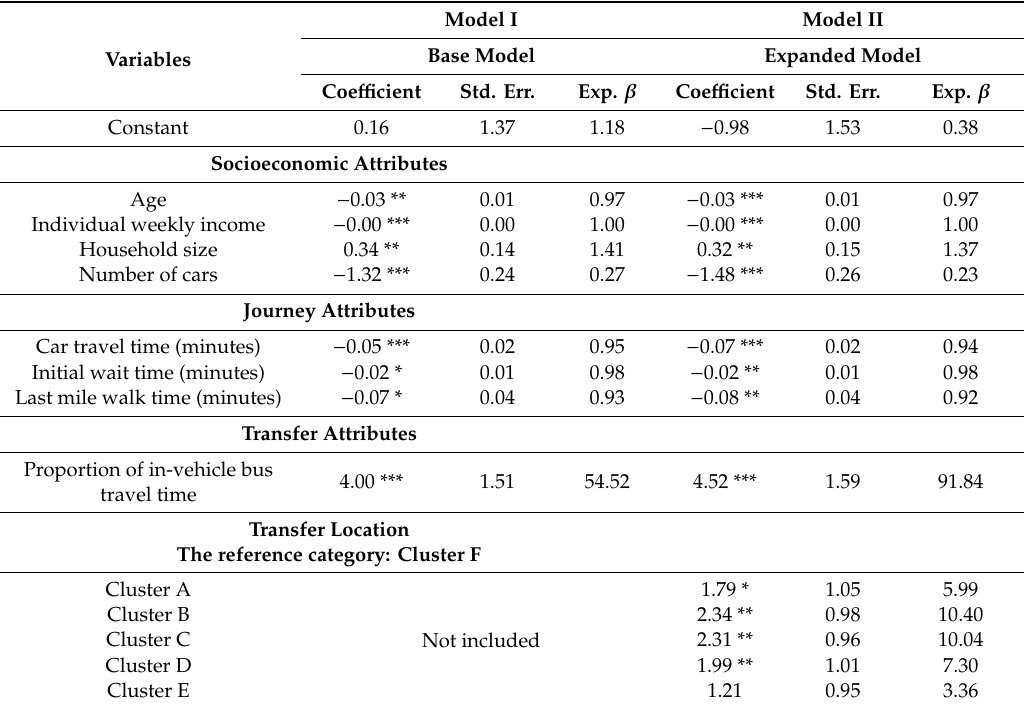
Table 3. Binomial logit model results: transfer location as nominal